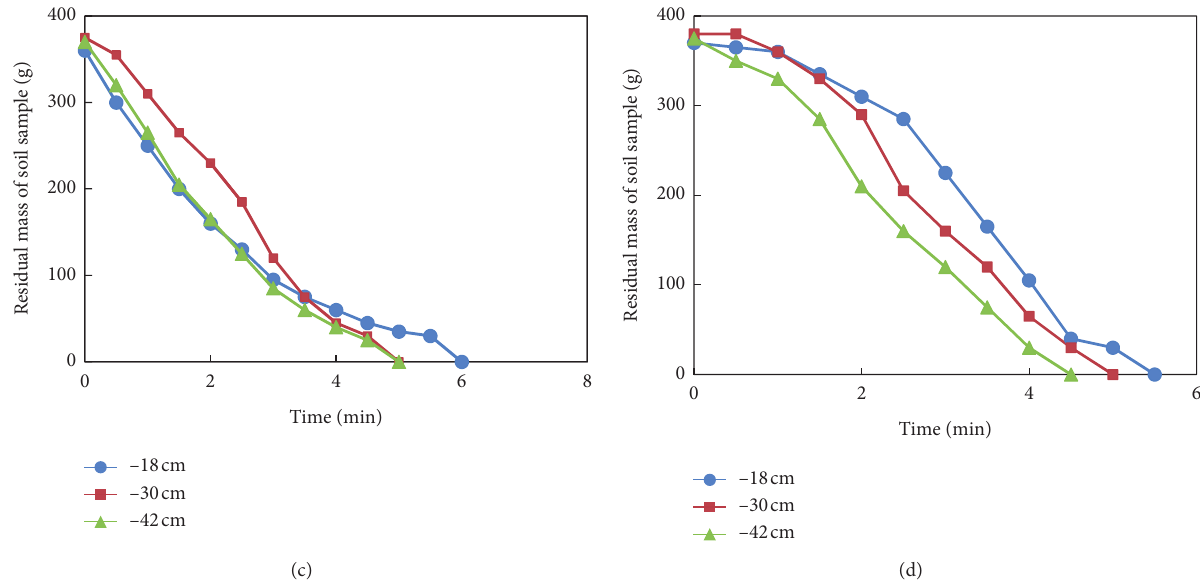
Figure 3: Disintegration curve of soil samples with the same volume at different water depth, (a) quadrangular prism of 10cm section side length, (b) cylinder of 10cm section diameter, (c) quadrangular prism of 12 cm section side length, (d) cylinder of 12cm section